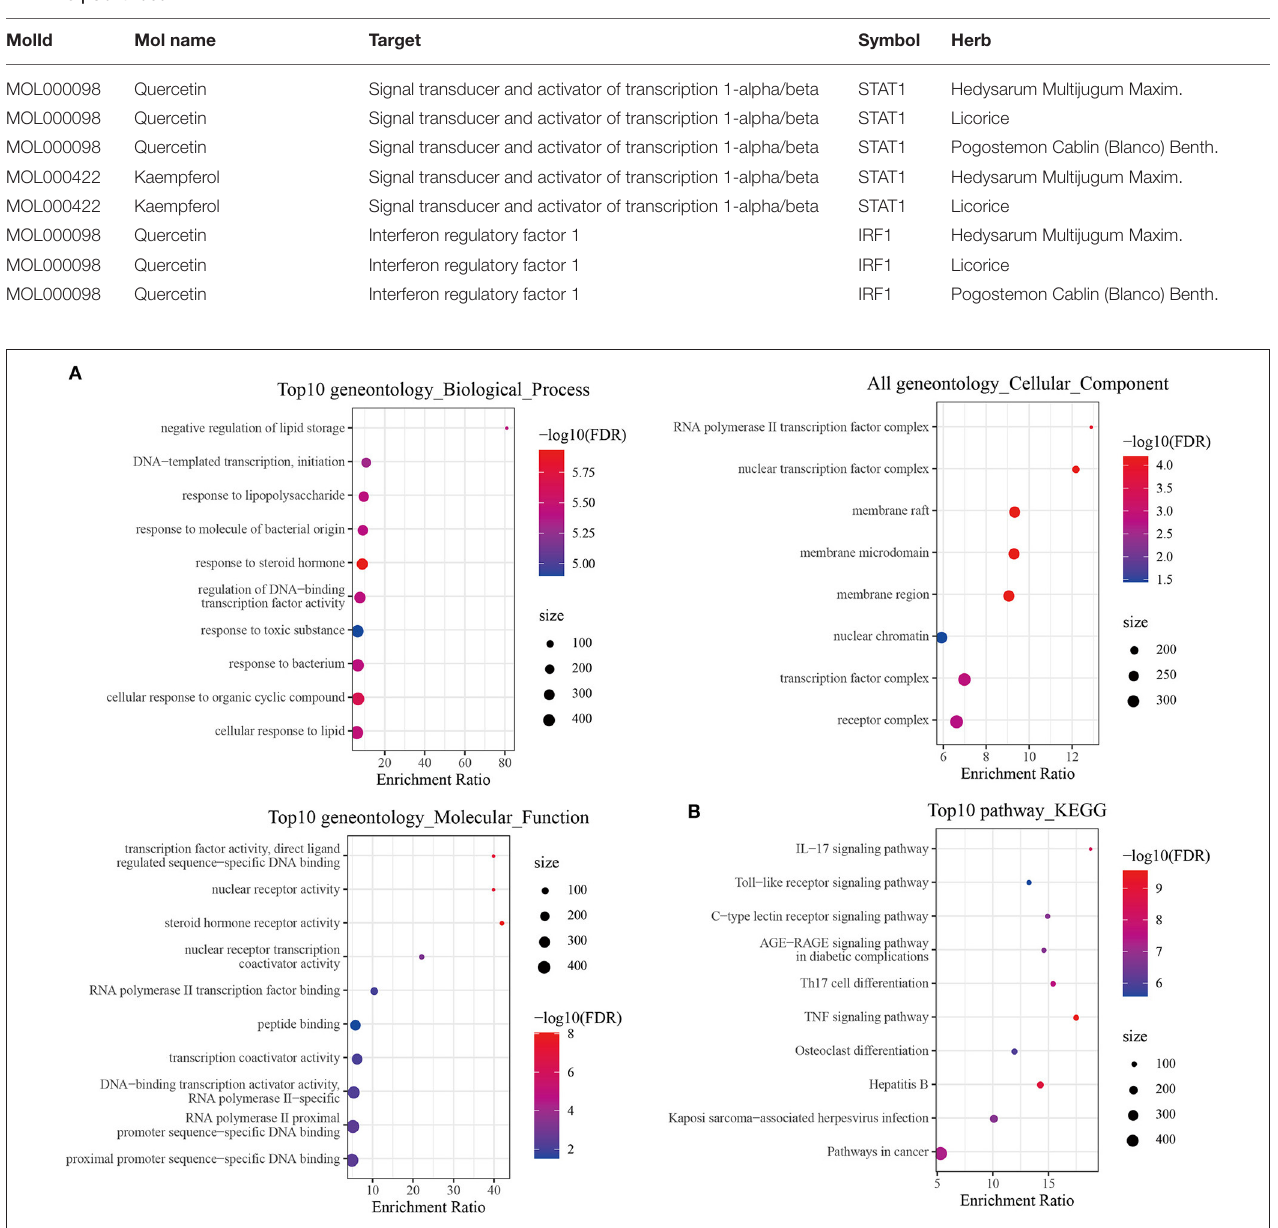
FIGURE 4 | GO and KEGG analysis of FPQXZ target genes. (A) GO terms of FPQXZ target genes. The top 10 GO functional categories were selected. (B) KEGG bubble diagram showed the top 10 pathways of FPQXZ target genes.